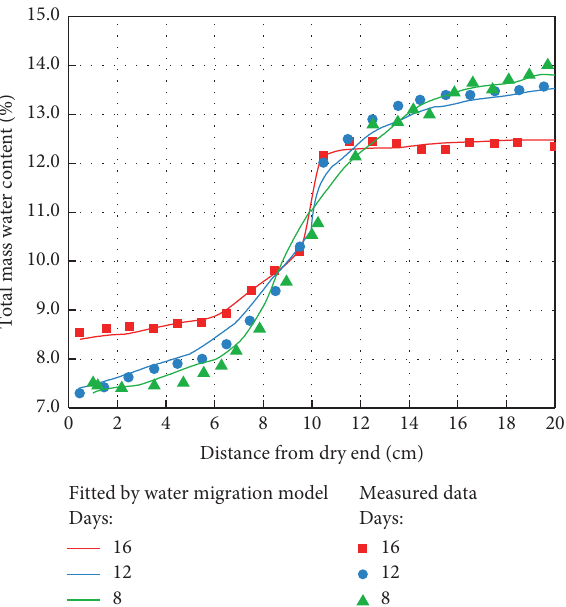
Figure 9: Fitted and measured mass water contents after days 8, 12, 16, and 20 of water